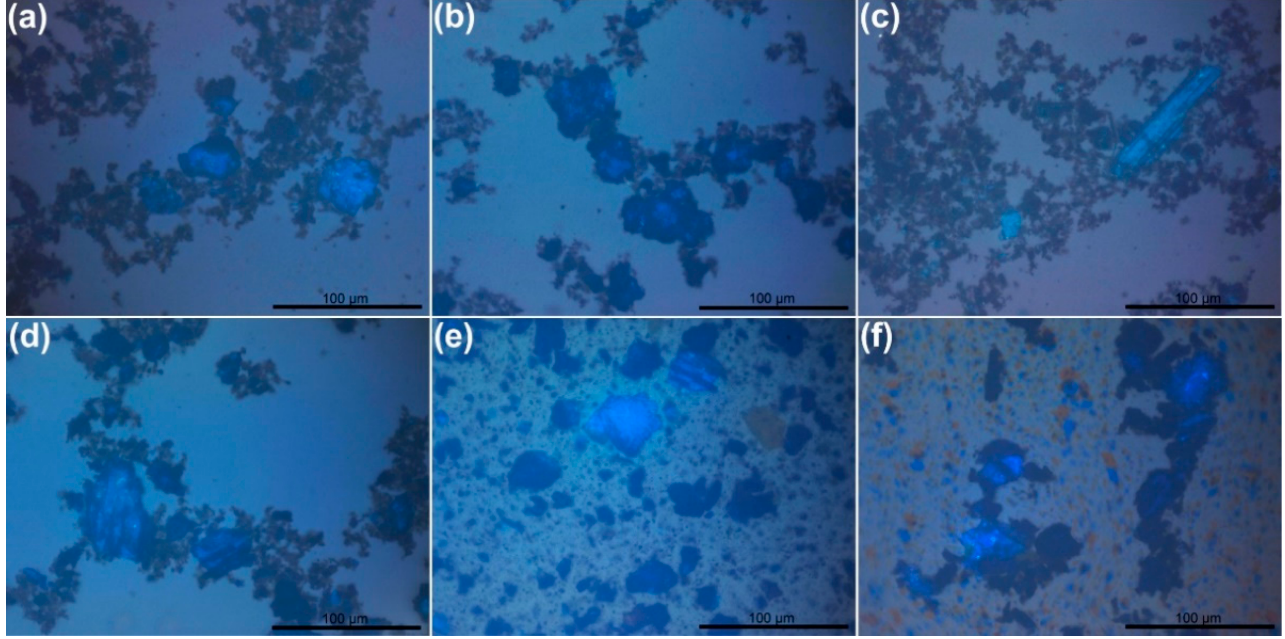
Figure 1. Optical micrographs of GBS obtained after 2 h from the start of the synthesis—A000 ( a ), A100 ( b ), P000 ( c ), P100 ( d ), C000 ( e ), and C100 ( f ).